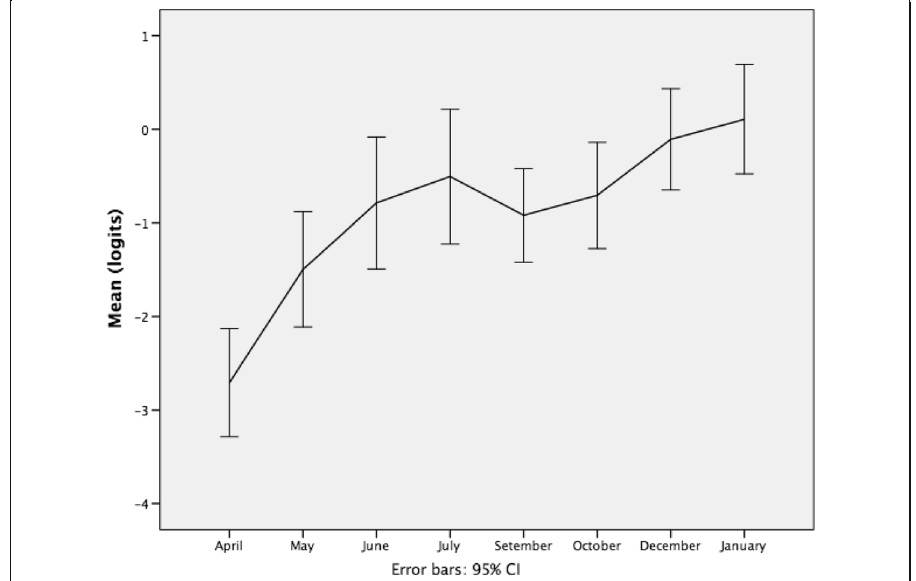
Fig. 1 Group mean for self-efficacy measures over the academic